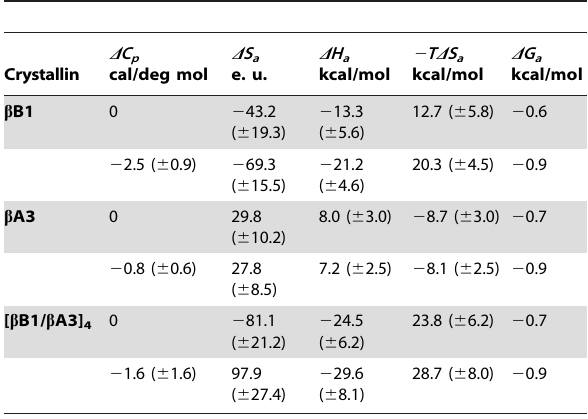
Table 1. Thermodynamic profiles for the associations of homodimeric b B1 and b A3 and tetrameric b B1/ b A3.